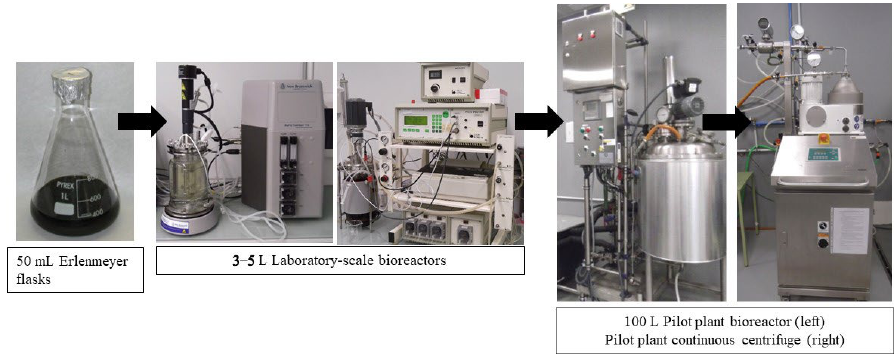
Figure 3. Liquid production process optimization.